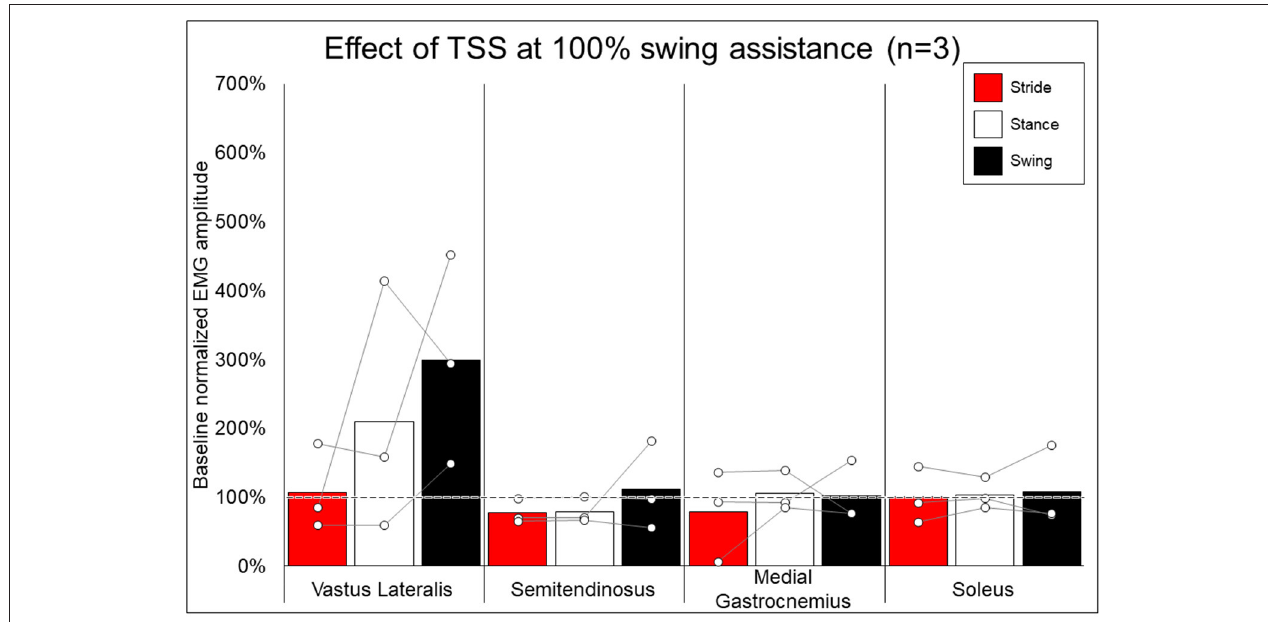
FIGURE 7 | Effect of adding trans-spinal stimulation to exoskeletal assisted walking at 100% swing assistance. Bars representing group averages and dots representing individual participants show EMG amplitudes during Min% normalized as a percent of average EMG amplitudes when walking at 100% assistance (represented by the dotted line on the graph).